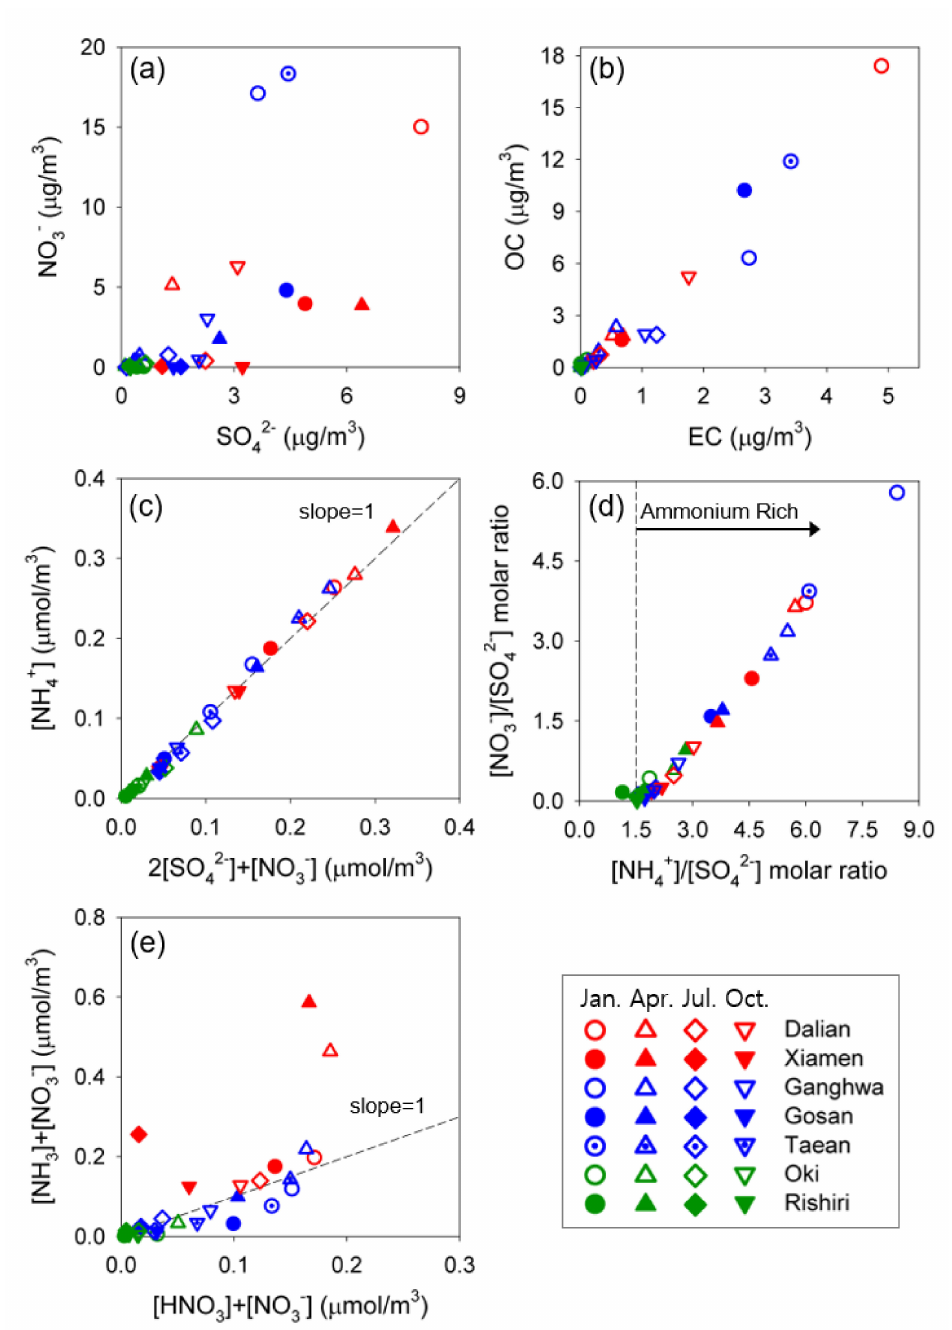
Figure 9. Simulated monthly mean ( a ) NO 3 − /SO 42 − ratios, ( b ) OC/EC ratios, ( c ) [NH 4+ ]/(2[SO 42 − ] + [NO 3 − ]), ( d ) NO 3 − -to-SO 42 − molar ratios vs. NH 4+ -to-SO 42 − molar ratios, ( e ) adjusted gas ratios defined as ([NH 4+ ] + [NO 3 − ])/([HNO 3 − ] + [NO 3 − ]) at seven remote sites in China, Japan, and